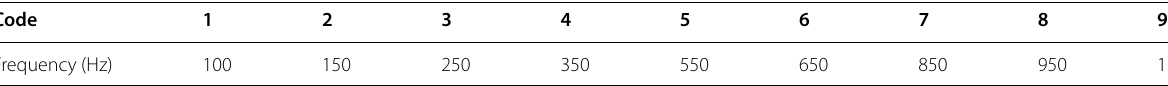
Table 1 Frequencies used to generate the IDs